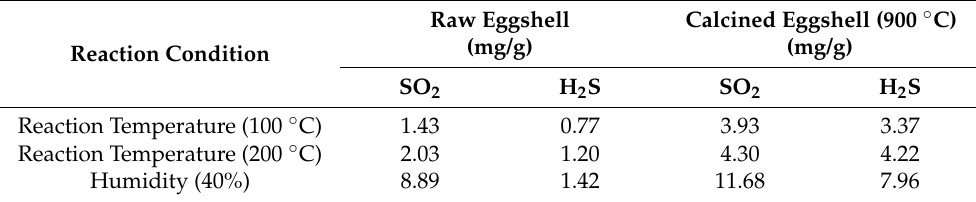
Table 6. Adsorption capacity of raw and calcined (900 ◦ C) eggshell at different reaction temperature and 40% relative humidity.